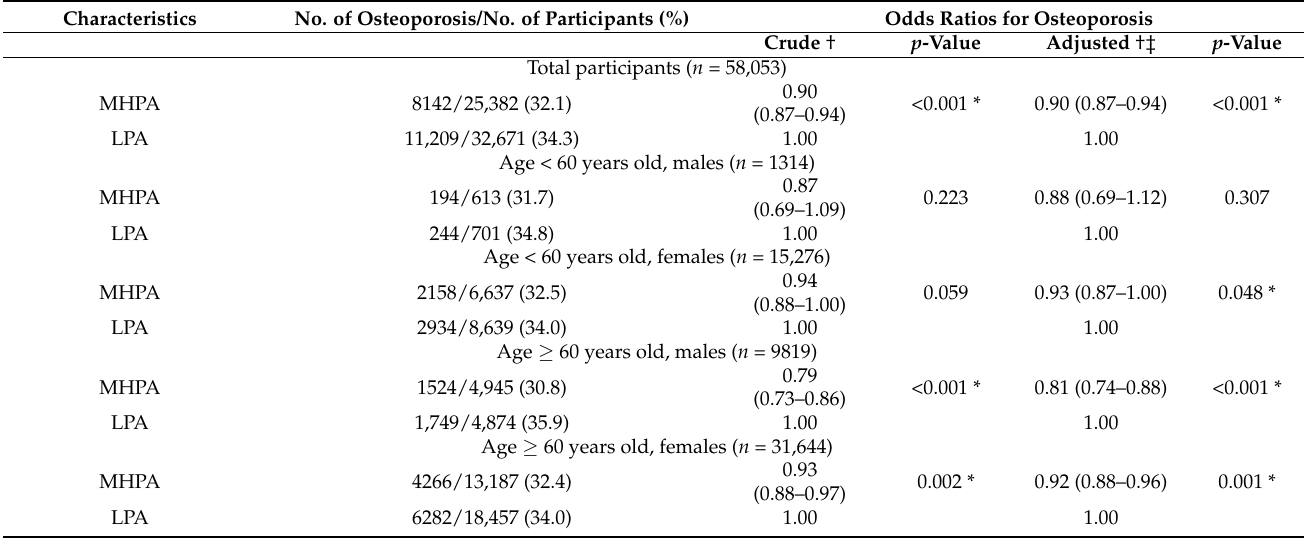
Table 2. Crude and Adjusted Odds Ratios (95% Confidence Intervals) of Moderate- to High-Intensity Physical Activity for Osteoporosis with Subgroup Analyses According to Age and Sex.